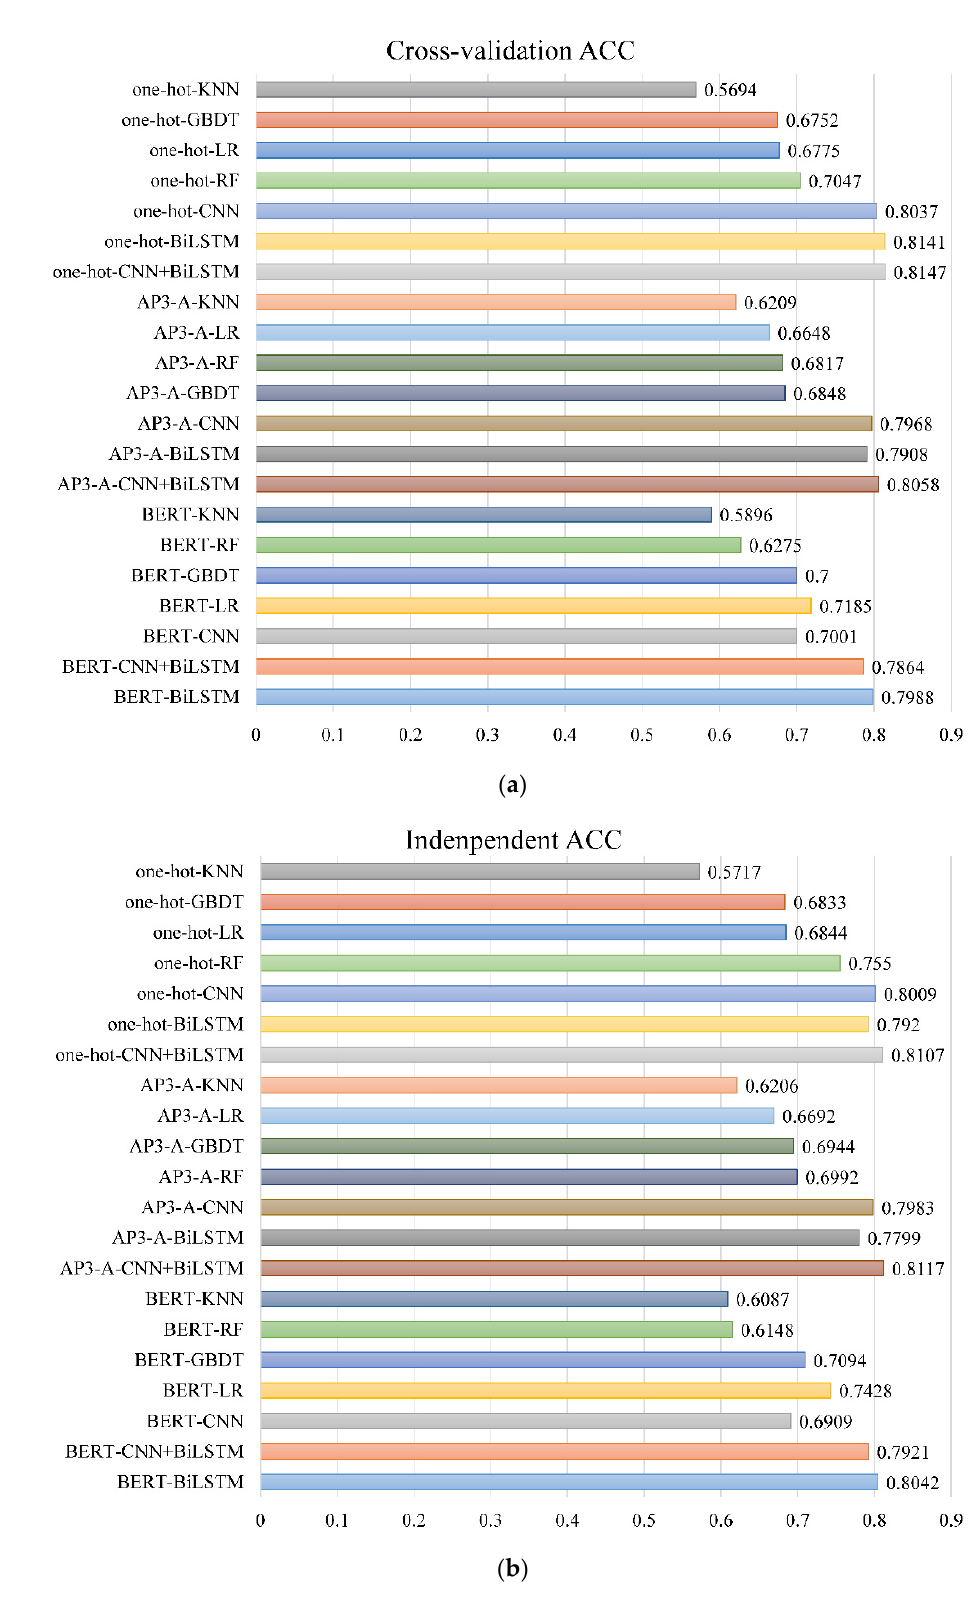
Figure 1. Performance of different methods on the Homo sapiens dataset: ( a ) 5-fold cross-validation mean results of 21 methods; ( b ) Independent test results of 21 methods.